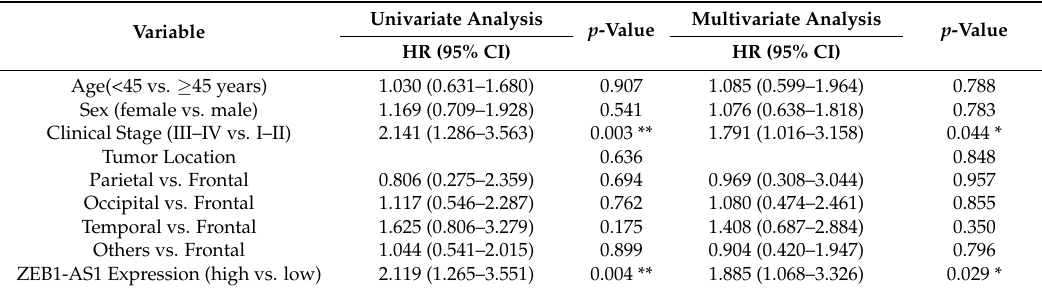
Table 2. Univariate and multivariate analyses of overall survivor (OS) rates in 82 glioma patients by Cox regression analysis.